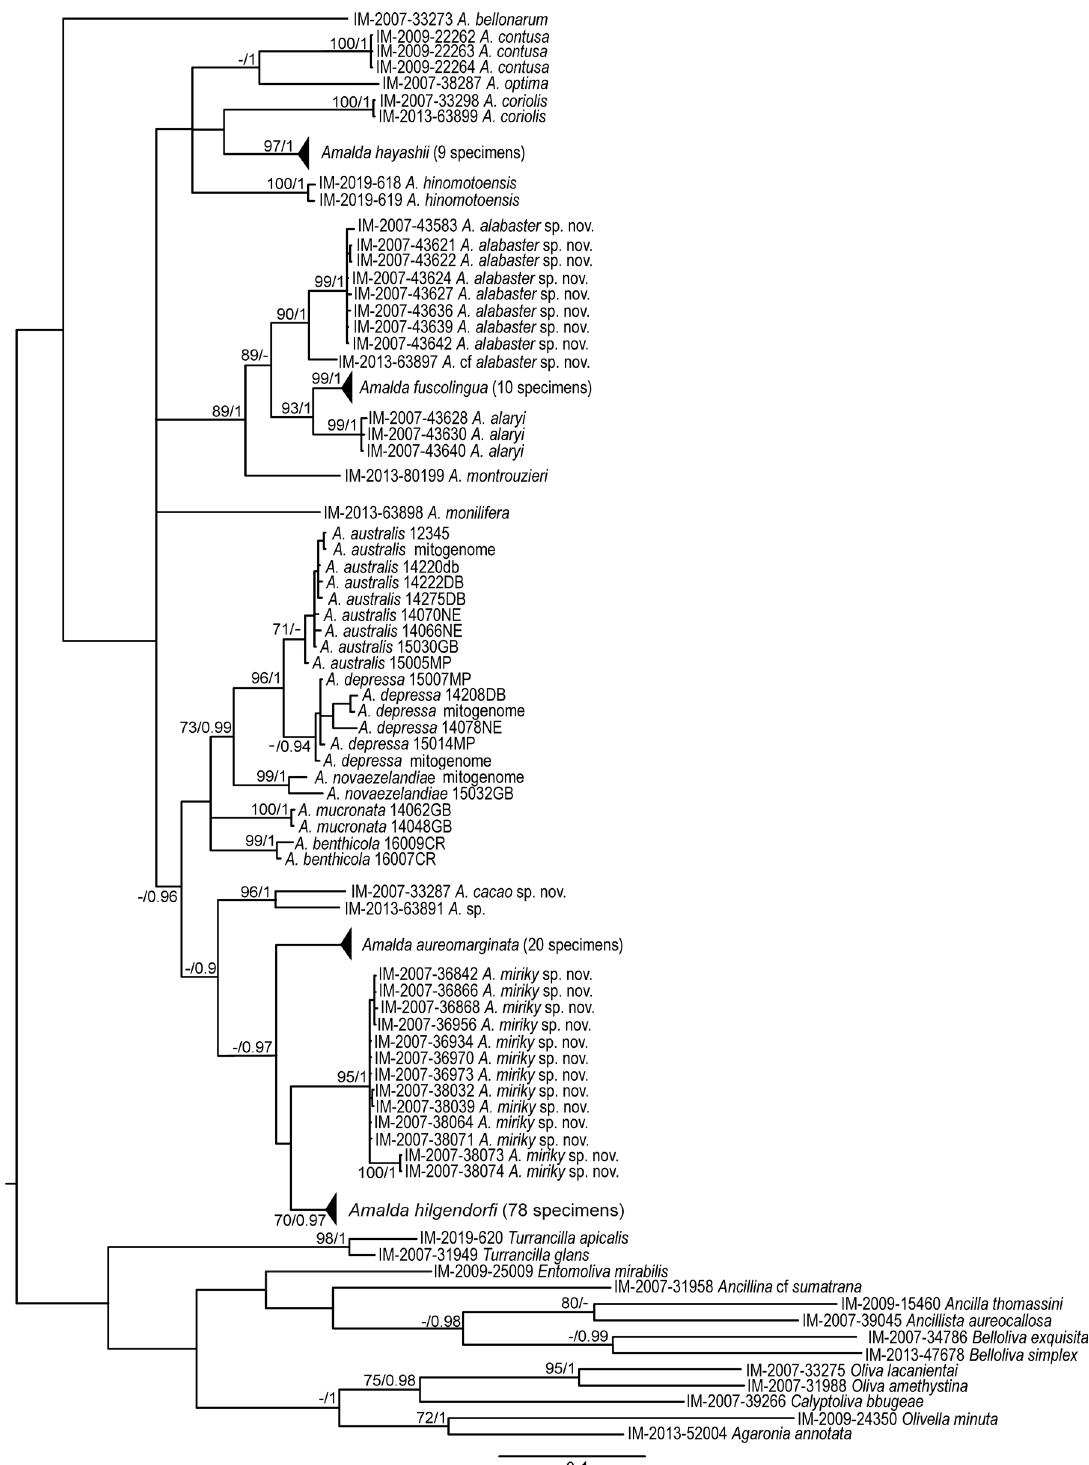
Fig. 1. Bayesian tree (MrBayes) for the Cox1 gene. Bootstrap supports (≥ 70) and posterior probabilities (> 0.90) values are shown for each supported node. The unit for the scale is “substitutions/site”. The clades of Amalda hayashii Ninomiya, 1988, A. fuscolingua Kilburn & Bouchet, 1988 and A. aureomarginata Kilburn & Bouchet, 1988 containing multiple specimens with minimal genetic distances are collapsed. The clade of A. hilgendorfi (von Martens, 1897) is collapsed and shown on Fig.